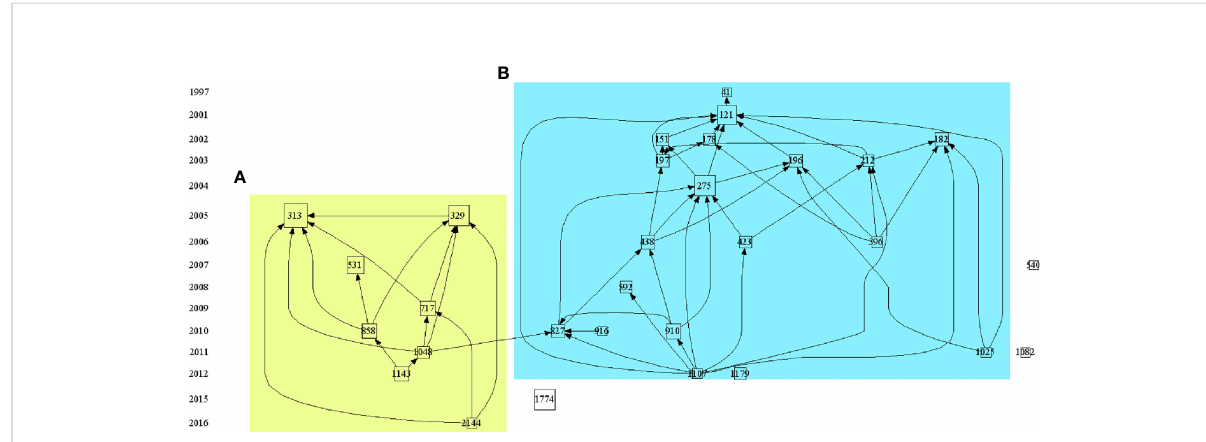
FIGURE 5 The citation path evolution of PTMs in the cancer fi eld. Source: authors with HistCite. Each node represented one highly cited paper. If paper B cites paper A, there is a line between paper A and paper B, and this line ’ s arrow pointed to paper B. The size of each node was proportional to the LCS of this paper, larger the node area, the higher the LCS. The yellow background (A) represents histone PTMs and the blue background (B) represents non-histone PTMs Publication information corresponding to the node was listed in Table